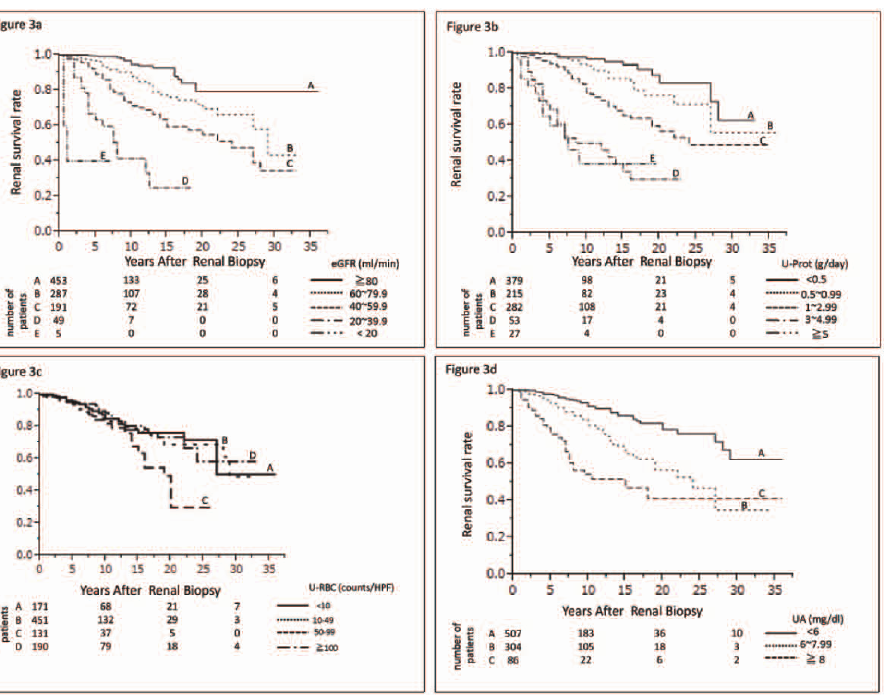
Figure 3. Cumulative renal survival rates in IgAN patients categorized by eGFR, U-Prot, U-RBC and uric acid concentration. (a) The 30-year survival rates of patients with eGFR . 80 ml/min/1.73m 2 , between 80 and 60 ml/min/1.73m 2 , and between 60 and 40 ml/min/1.73m 2 were 80.1%, 43.1%, and 34.6%, respectively. The survival rates of patients with eGFR between 40 and 20 ml/min/1.73m 2 and , 20 ml/min/1.73m 2 were 24.8% over 18 years and 40.0% over 7 years, respectively. The difference among groups was statistically significant (P , 0.0001). (b) The 30-year renal survival rates of patients with U-Prot , 0.5 g/day, between 0.5 and 1 g/day, and between 1 and 3 g were 62.6%, 55.6%, and 49.0%, respectively. The survival rates of patients with U-Prot between 3 and 5 g/day and . 5 g/day were 29.9% over 20 years and 34.4% over 15 years, respectively. The difference among groups was statistically significant (P , 0.0001). (c) The 30-year renal survival rates of patients with U-RBC , 10 counts/HF, between 10 and 49 counts/HF, and $ 100 counts/HF were 50.2, 49.0, and 41.7%. The survival rates of patients with U-RBC between 50 and 99 counts/HF was 29.6% over 25 years. The difference among groups was not statistically significant (P=0.1122). (d) The 30-year renal survival rates of patients with uric acid , 6 mg/dl, between 6 and 8 mg/dl, and . 8 mg/dl were 62.3, 35.1, and 41.2%, respectively (P , 0.0001).